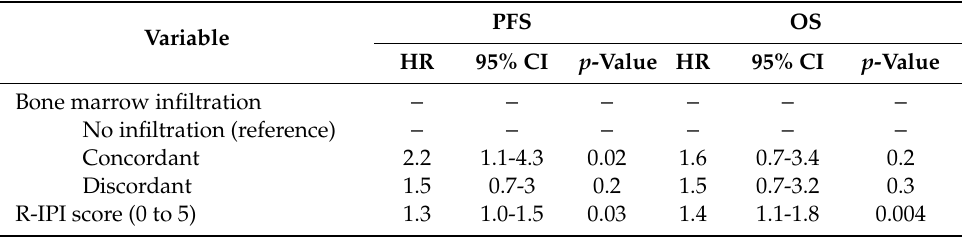
Table 4. Multivariate analysis of progression-free survival and overall